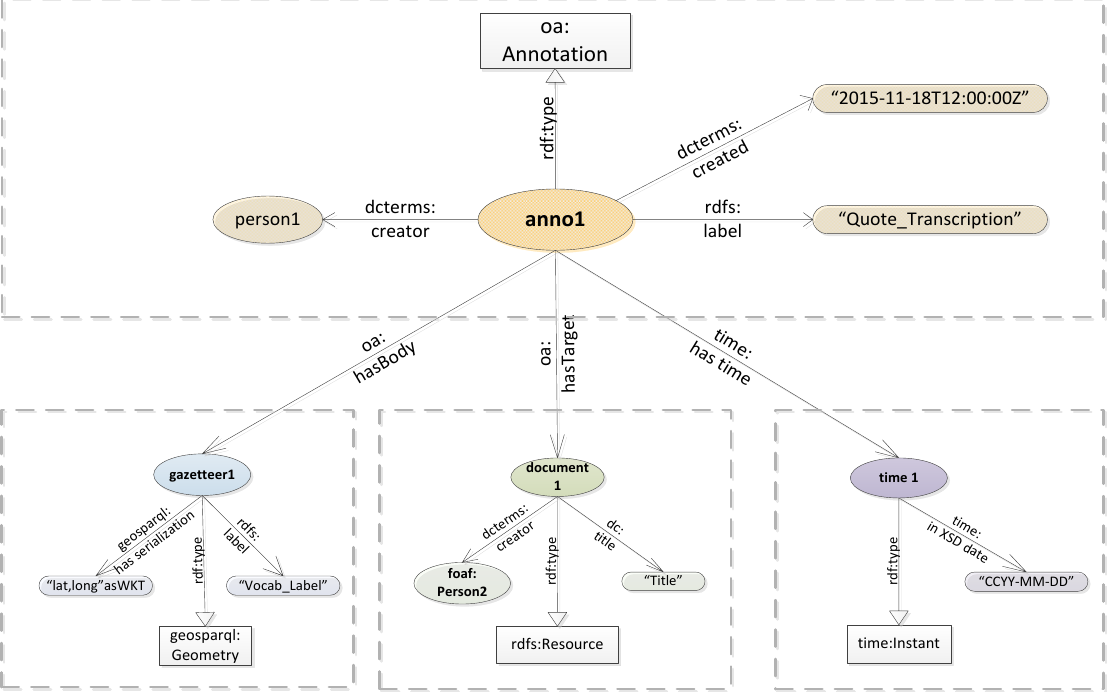
The TLCMap ontology builds upon the OAC ontology model and is extended to